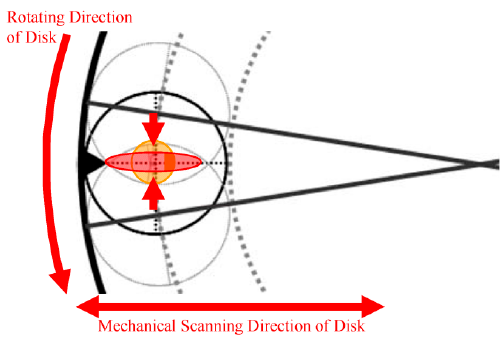
Figure 11. Configuration of the disk, the wafer and the beam spots [23]. Two kinds of beam spot shapes are prepared; Round shape: reference; Oval shape: to shorten the beam irradiation time.